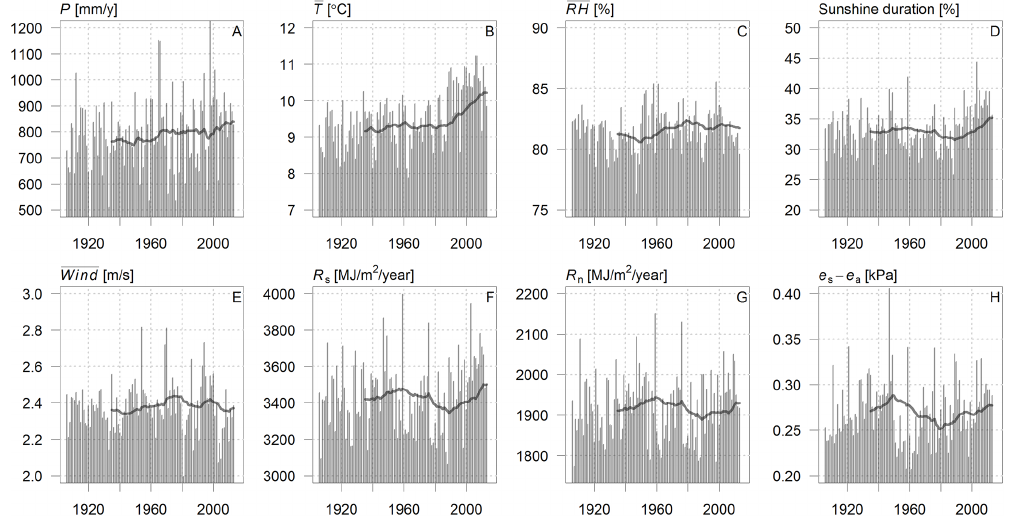
Figure 3. Annual and 30-year moving average variables for De Bilt meteorological station. (a) Precipitation, (b) mean temperature, (c) mean relative humidity, (d) sunshine duration, (e) mean wind speed, (f) global radiation, (g) net radiation, and (h) vapor pressure deficit. (a) – (e) are observations, and (f) – (h) are calculated following Allen et al.